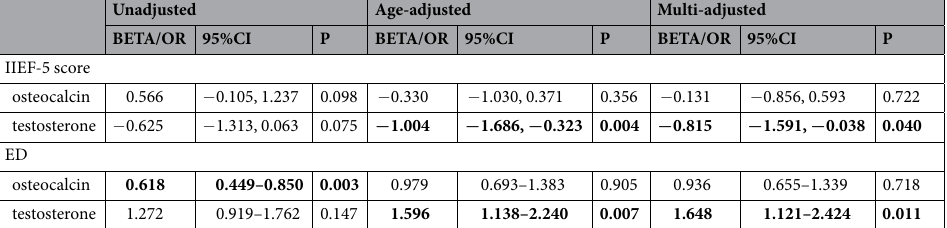
Table 2. The linear and binary logistic regression analyses for the association between osteocalcin, testosterone and ED. * In the linear regression analysis, as a continuous variable the IIEF-5 score is treated as the dependent factor. In the binary logistic regression analysis, ED (dichotomous variable: ED or without ED) is treated as the dependent factor. * ED: erectile dysfunction; BMI: body mass index; WHR: waist hip rate; OR: odd ratio; 95%CI: 95% confidence interval. * Multi-adjusted: age, BMI, WHR, smoke and drink.